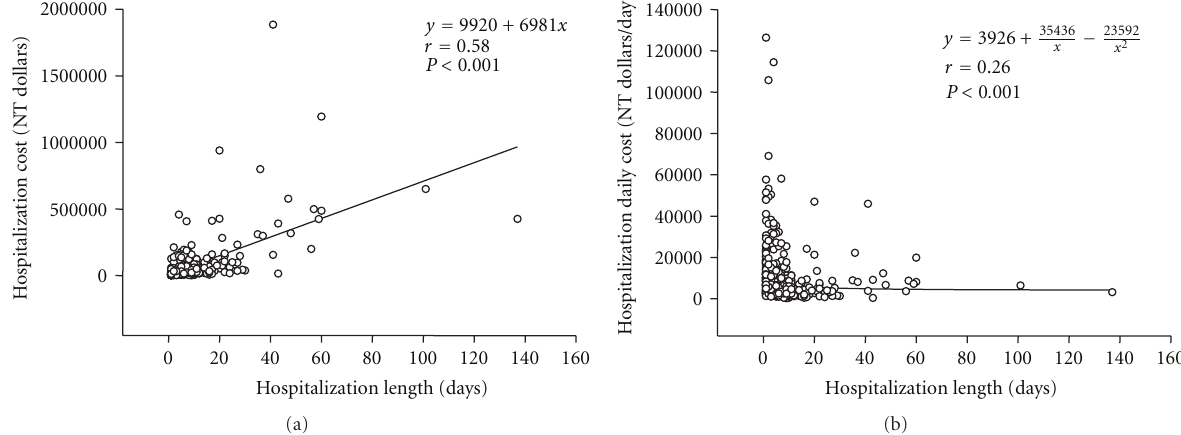
Figure 6: The correlation of hospital length and total cost or daily cost in AMI patients. The hospital length was linearly correlated with total cost (a) and inversely correlated with daily cost